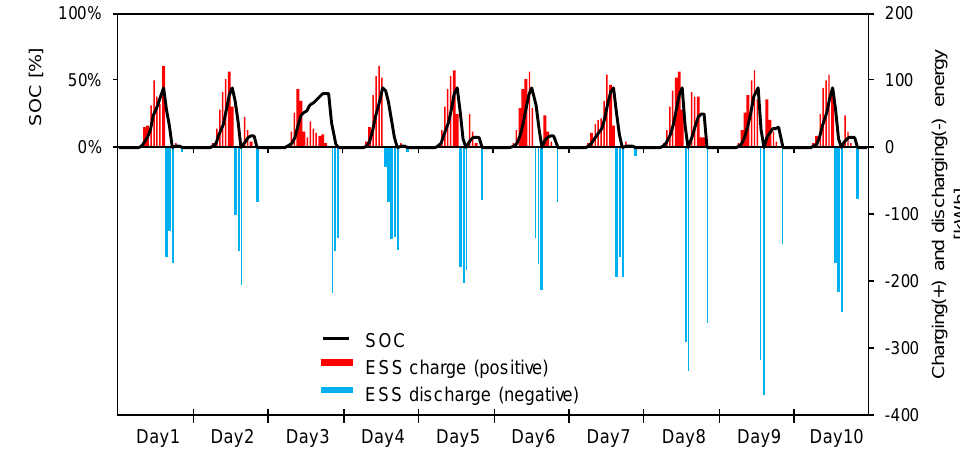
Figure 3. Self-consumption ESS schedule in mode 2.